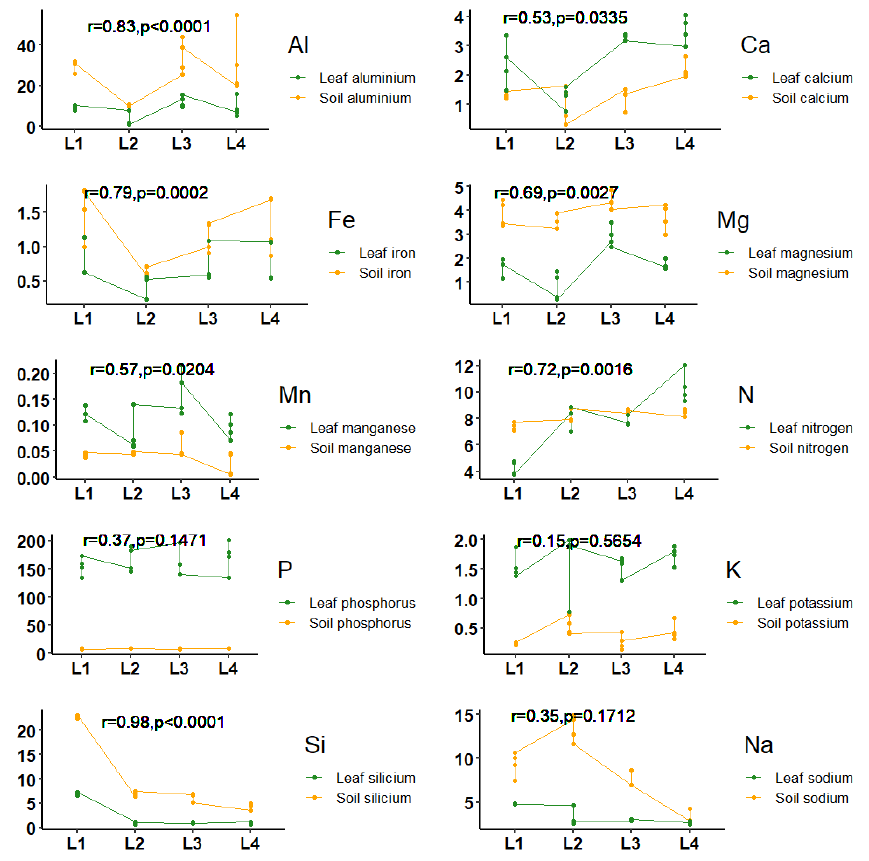
Figure 1. Correlations between soil and leaf chemical elements in the four studied localities.